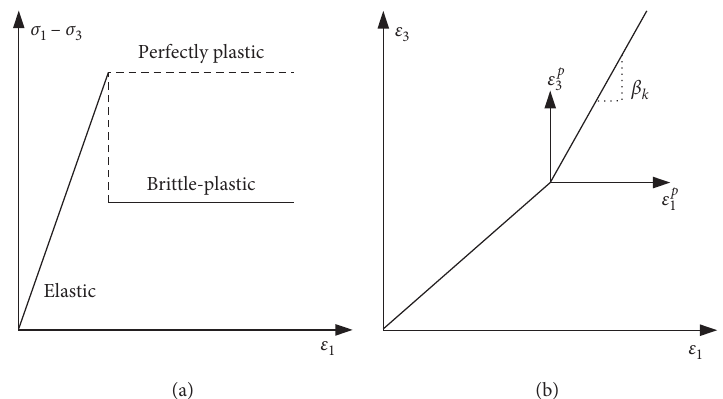
R R � R p > d ; (b) p d .